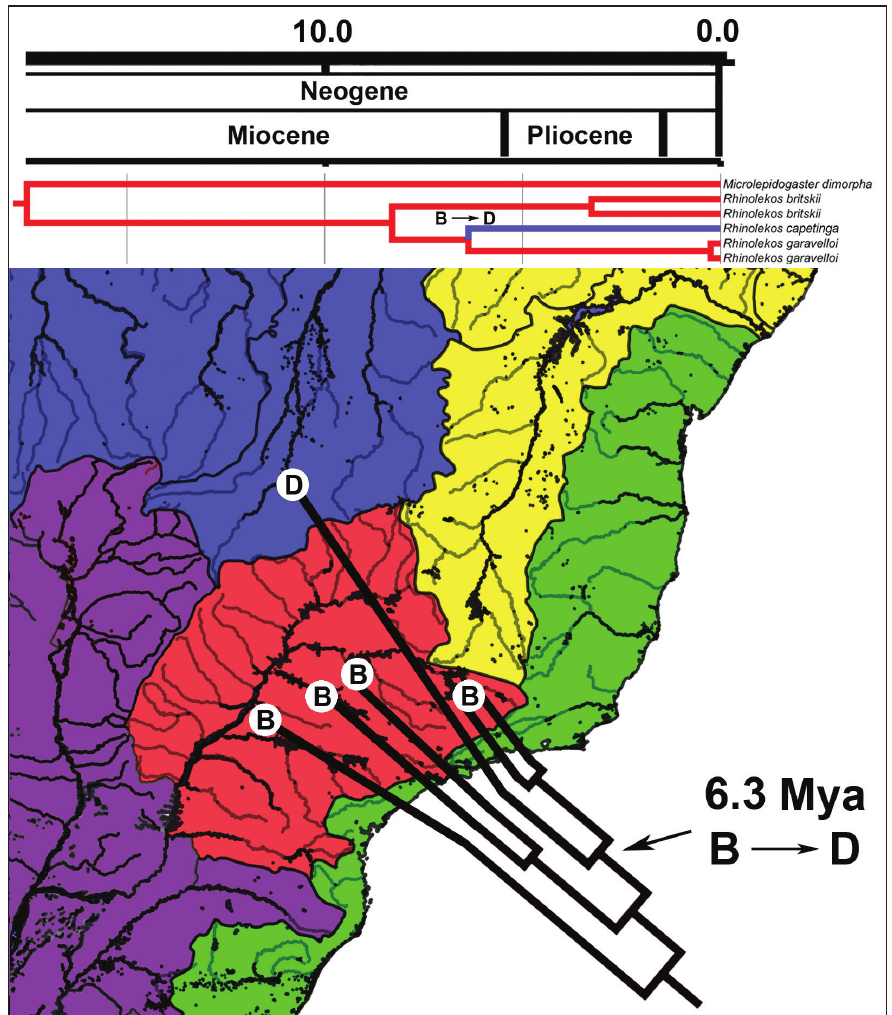
Figure 5. Biogeographic distribution and time-calibrated phylogenetic tree of Microlepidogaster and Rhi- nolekos species, based on three mitochondrial (16SrRNA, COI, Cytb) and one nuclear marker (F-reticu- lon 4), modified from figure 7 of Roxo et al. (2014a). The map colorations indicate distinct biogeographic regions according to classification available in Roxo et al. (2014a): Green – Coastal drainages ( A ); Red – upper rio Paraná basin ( B ); Purple – Paraguay, Lower Paraná and Uruguay basins ( C ); Blue – Amazon basin ( D ); Yellow – São Francisco basin ( E